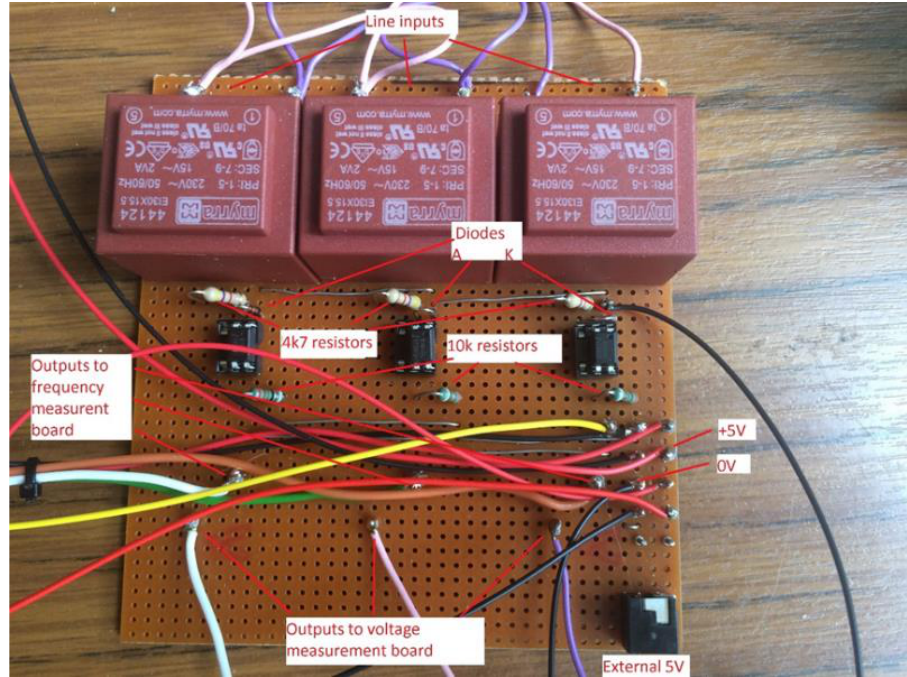
Figure 16. Baseline frequency measurement board implementation as developed by D. Mohapatra in [6].